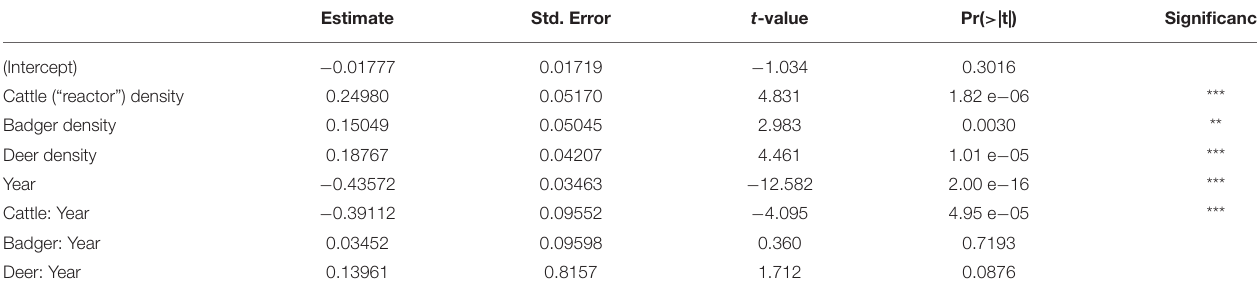
TABLE 2 | Output from the GLM of individual-level analysis. Estimate Std.